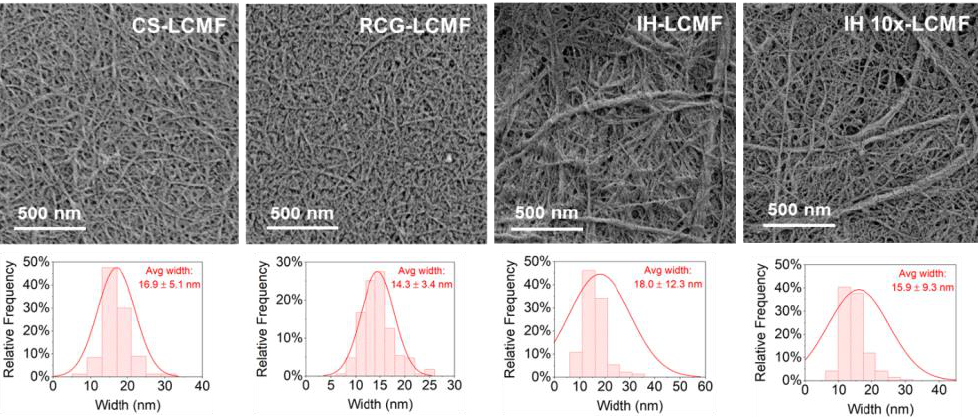
Figure 6. AFM images and size distribution curves of LCNF from different biomass feedstocks.